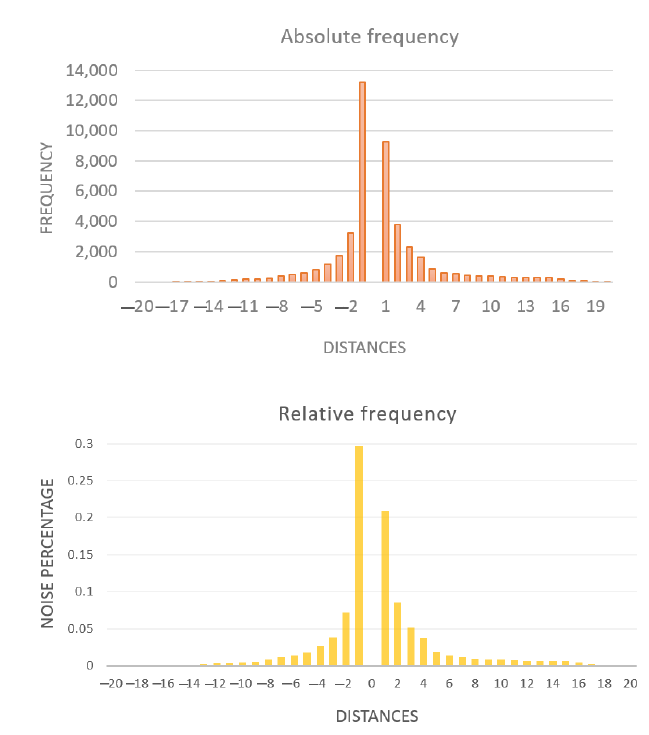
Figure 12. Absolute and relative frequency distributions of noise acquisition in binary